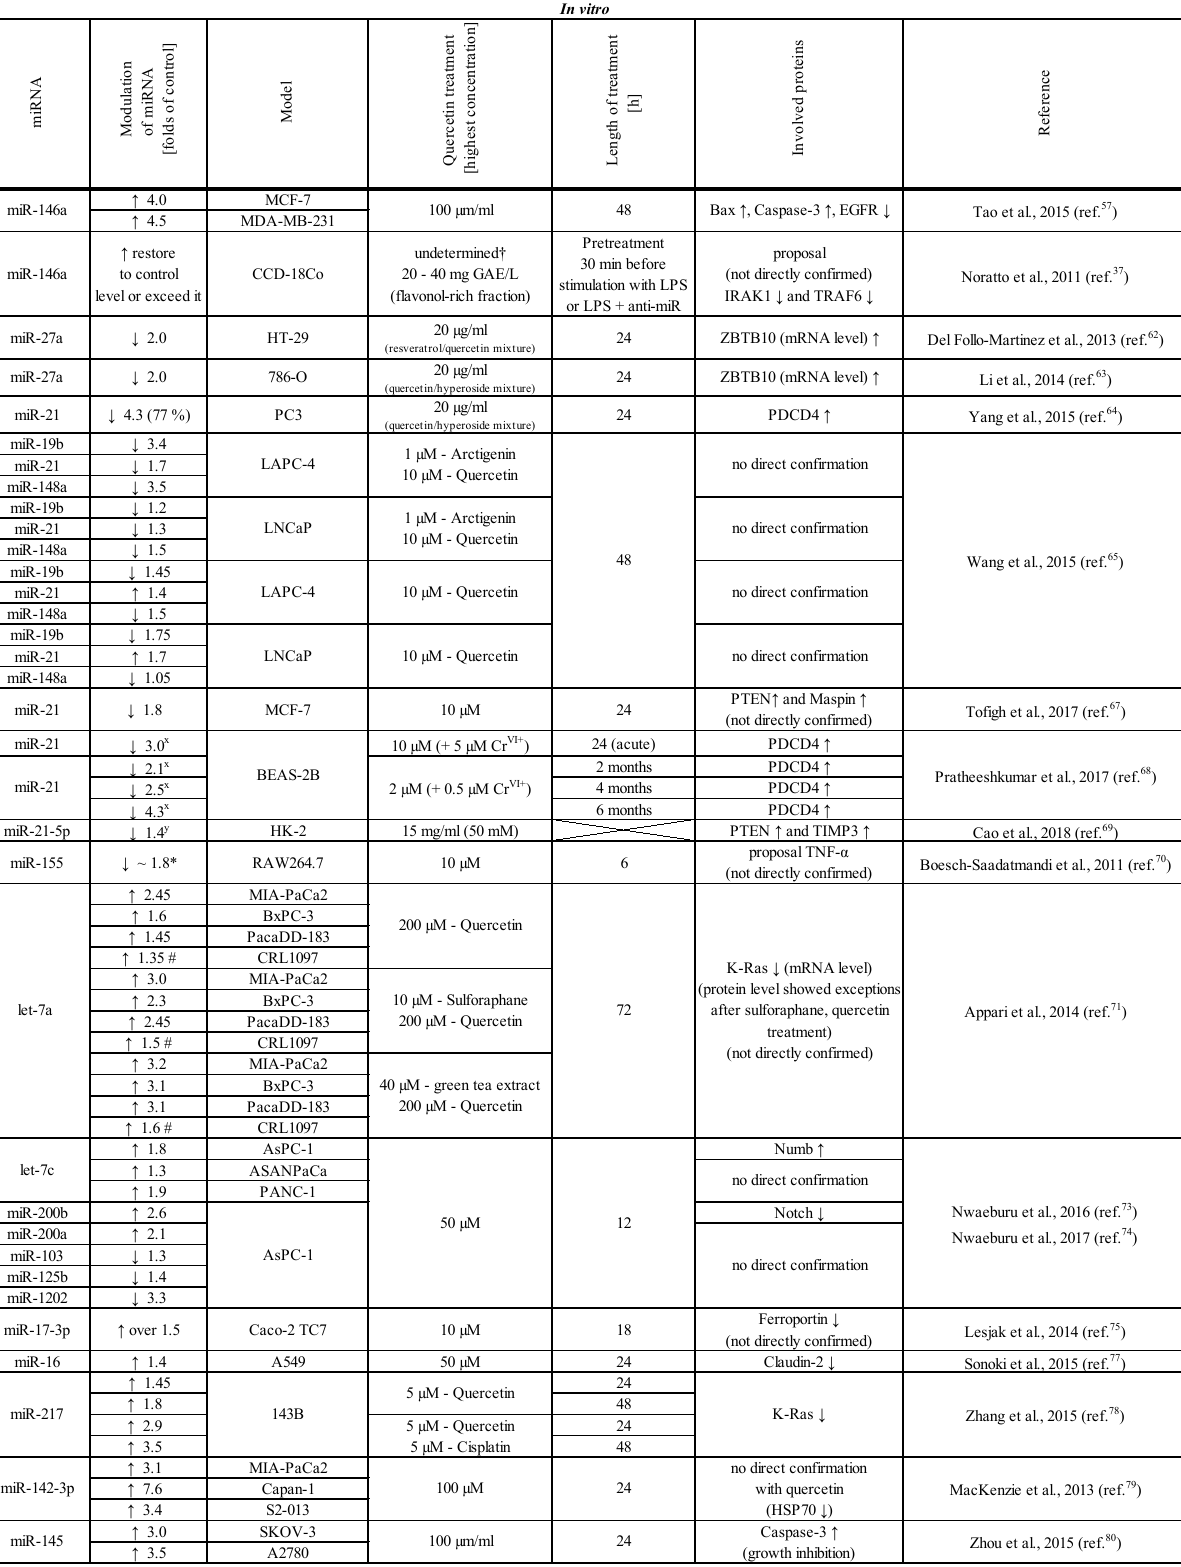
Table 1. Summary of quercetin mediated miRNAs with modulated targets and treatment characteristics – in vitro . The values for miRNA expression were usually estimated from article